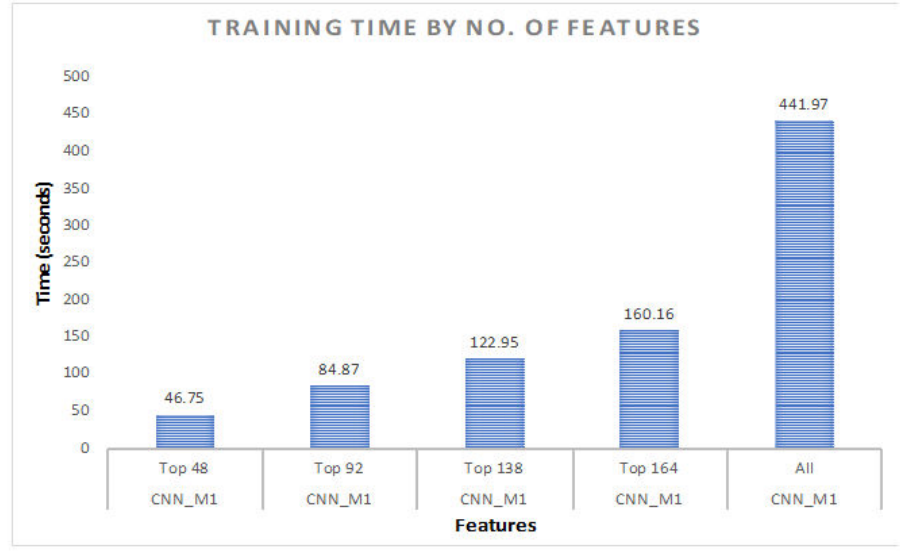
Figure 12. Training time by number of features for 70–10–20%.